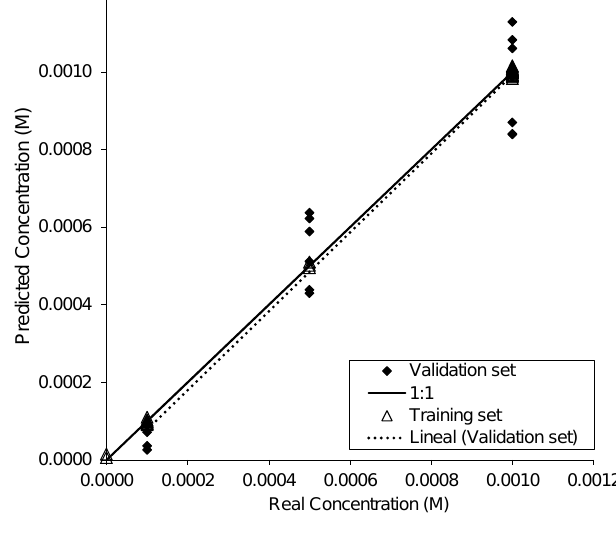
Figure 6. The results of the PLS prediction of glyphosate in phosphate buffer using the electronic tongue and rotating disk